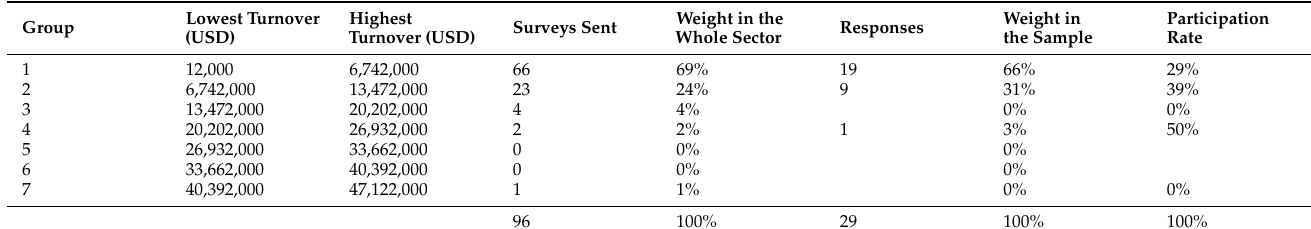
Table 5. Frequency distribution by turnover